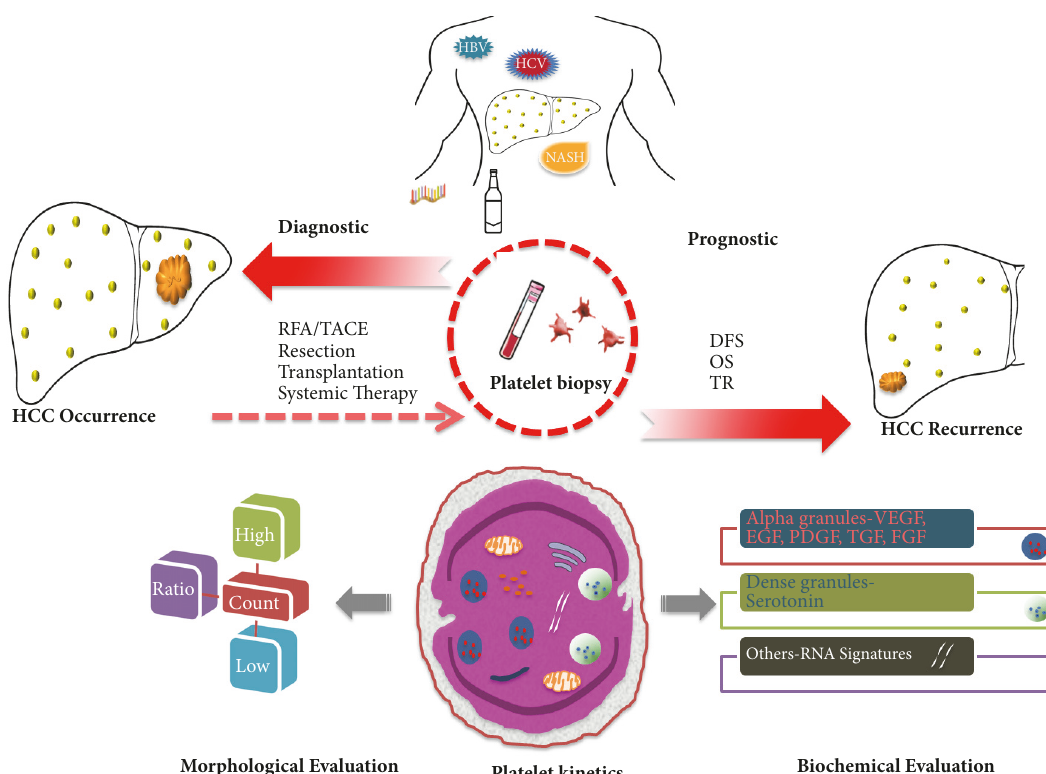
Figure 1: Schematic r ep r esentation of platelet-based dia g nostic and p r o g nostic model in HCC. Platelet may serve as a liquid biopsy in patients with underlying liver disease to detect or predict HCC occurrence. Posttreatment platelets, after locoregional therapy, resection, transplant, or systemic therapy, may also enable monitoring the prognosis including DFS, OS, and TR. The morphological abnormalities of platelets including thrombocytosis, thrombocytopenia, or platelet ratio with lymphocyte/neutrophil have been used to evaluate the diagnosis or prognosis of HCC. Platelet-derived growth factors (VEGF, EGF, PDGF, FGF, and serotonin) are differentially expressed and correlated with diagnosis or prognosis of HCC. Other emerging platelet-based tools like RNA signatures are yet to be tested in patients with HCC. (HBV, hepatitis B virus; HCV, hepatitis C virus; NASH, nonalcoholic steatohepatitis; HCC, hepatocellular carcinoma; DFS, disease-free survival;TACE,transarterialchemoembolization;RFA,radiofrequencyablation;OS,overallsurvival;TR,treatmentresponse;VEGF,vascular endothelial growth factor; EGF, epidermal growth factor; PDGF, platelet-derived growth factor; FGF, fibroblast growth